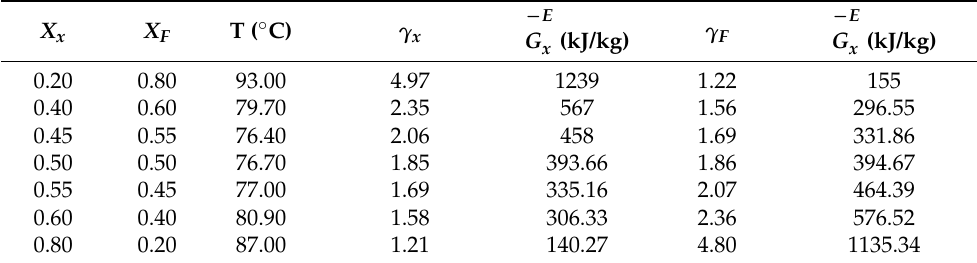
Table 2. Activity coefficient and Excess Gibbs Energy.